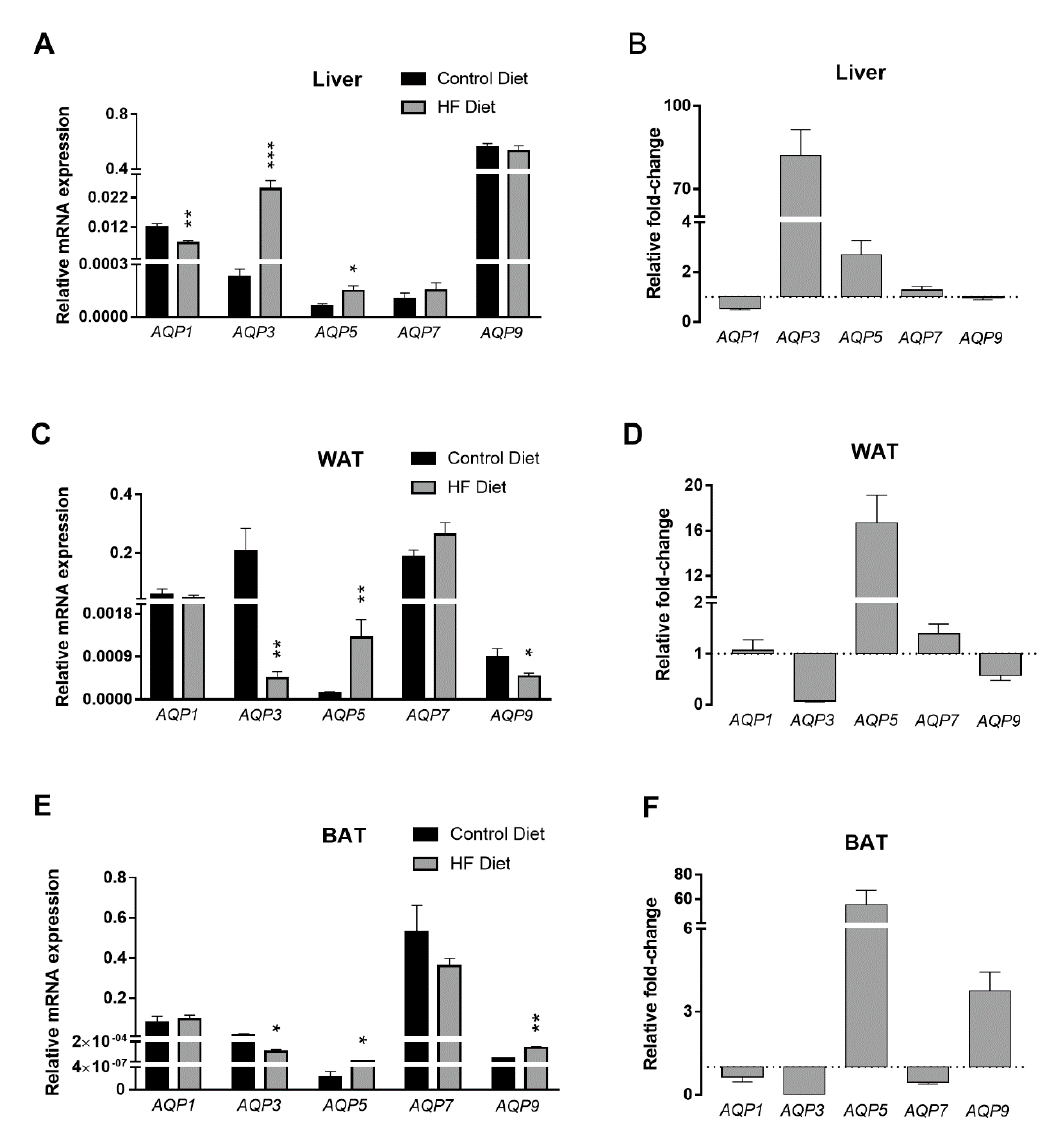
Figure 6. Aquaporins gene expression in apoE − / − mice fed control or atherogenic High-Fat (HF) diets. AQP1 , AQP3 , AQP5 , AQP7 and AQP9 expression in liver ( A ), WAT ( C ) and BAT ( E ) in mice fed control or HF diets and respective fold-change in HF-fed animals relative to controls [liver ( B ); WAT ( D ); and BAT ( F )]. Results are mean ± SEM (n = 8–10 per group). * p < 0.05; ** p < 0.01; *** p < 0.001; all HF versus control.